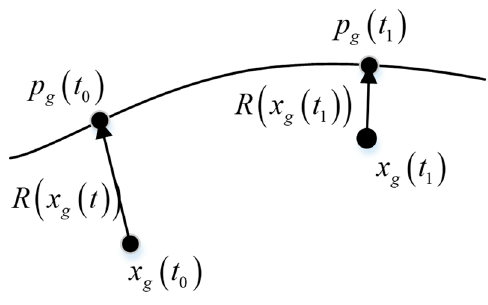
Figure 6. Effect of the tracking error convergence.